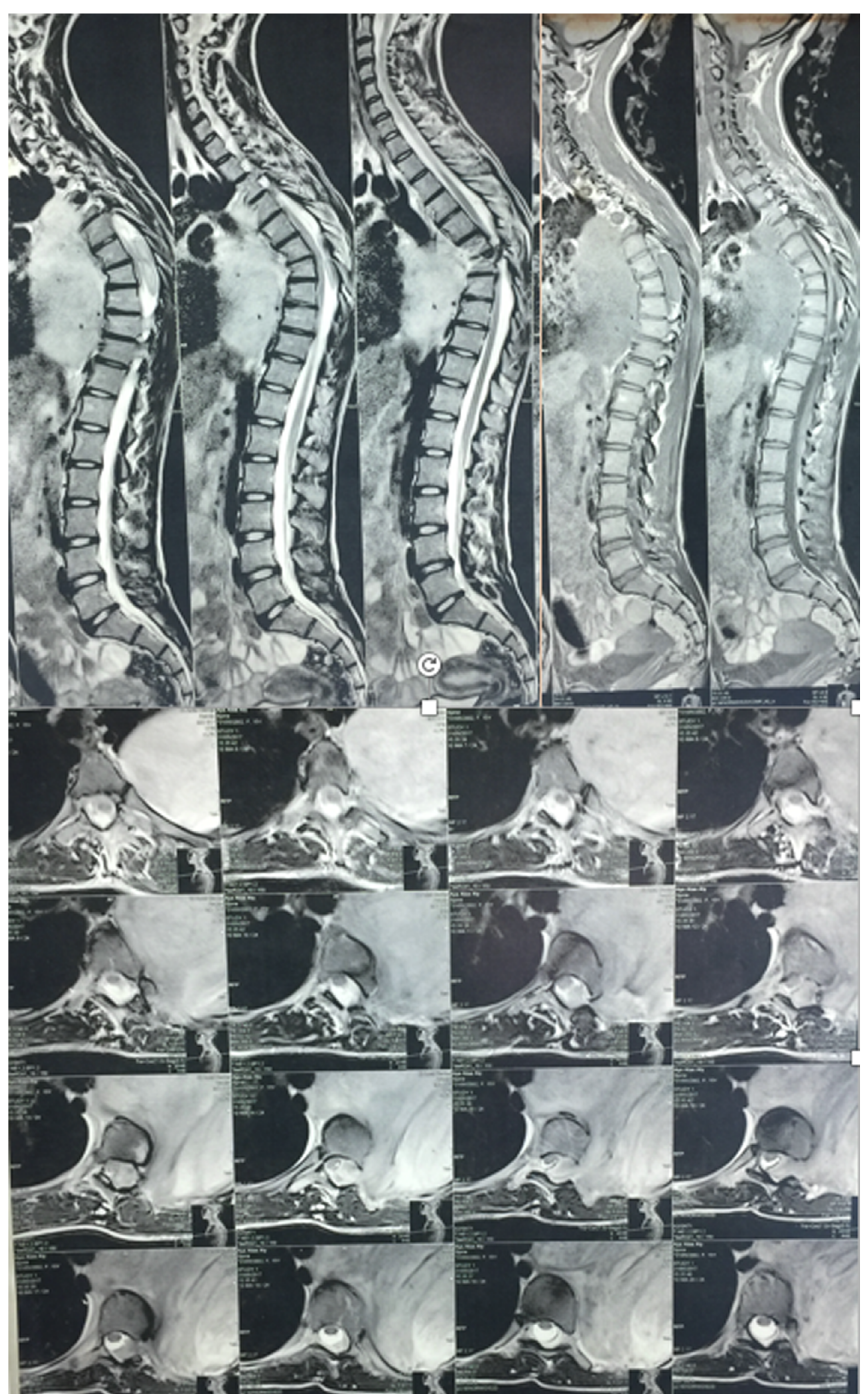
Figure 2. Preoperative MRI revealing a giant left extra pulmonary mass with intra spinal extension compressing the spinal